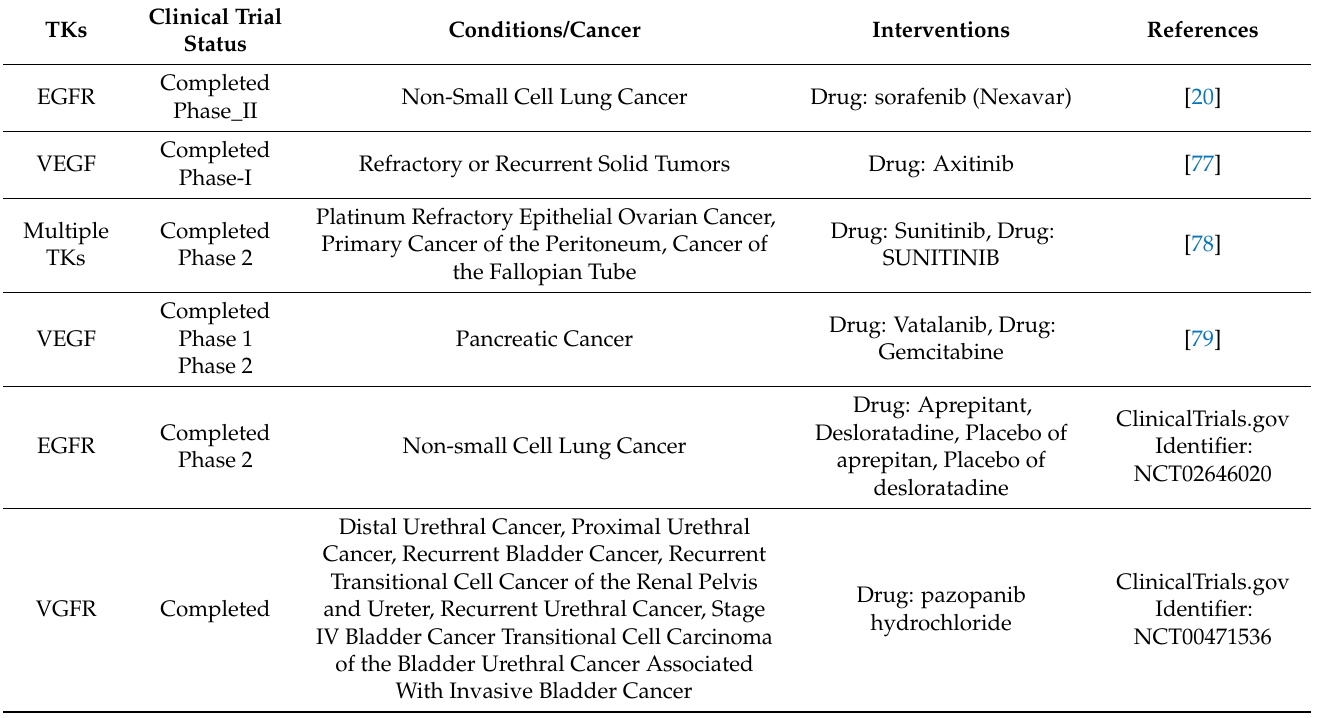
Table 2. Under top 40 selective RTKs inhibitors (drugs) in clinical trial for multiple